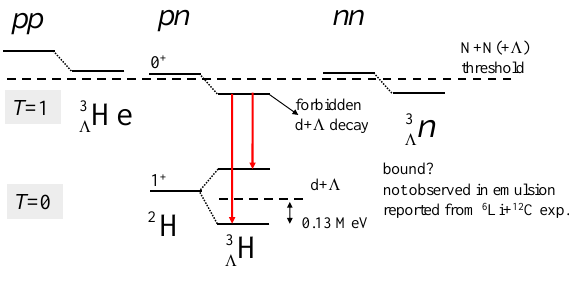
Figure 4. Level schemes of the NN and NN (cid:3) systems in case of the 3 (cid:3) n is bound as reported in the GSI